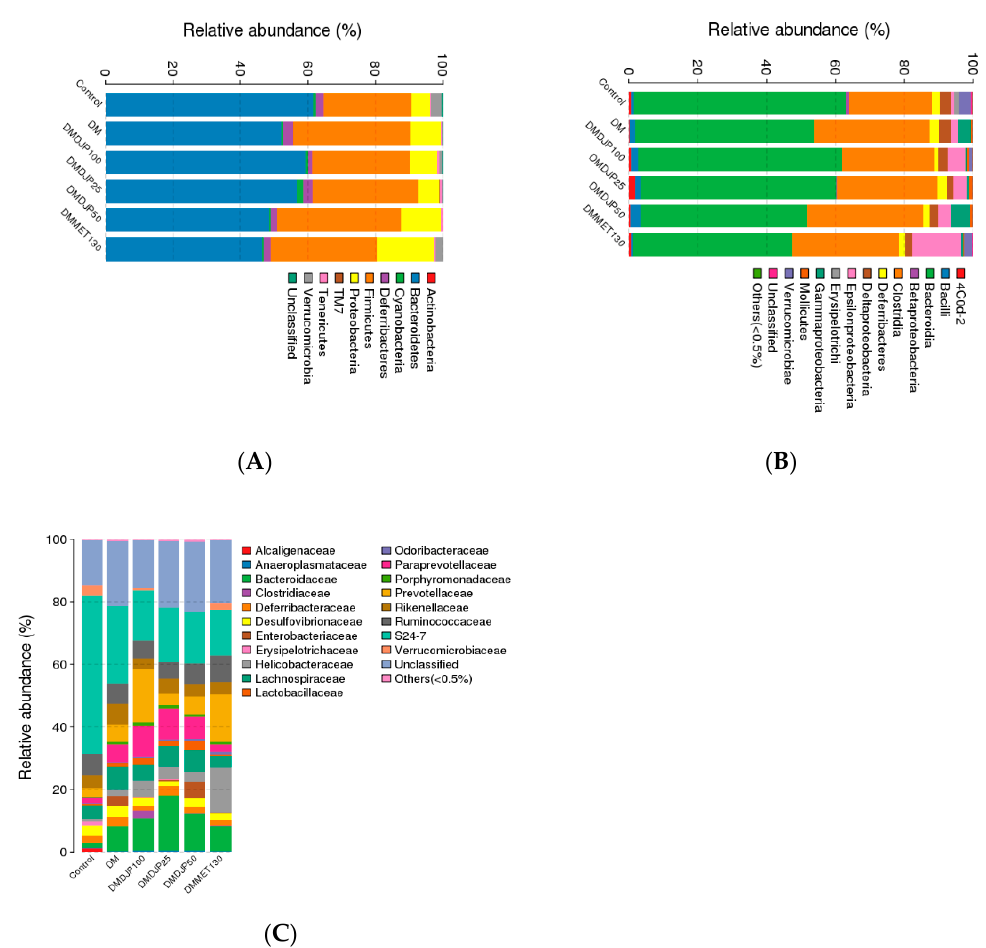
Figure 9. Taxonomic composition of gut microbiome in the mice. ( A ) Phylum-level; ( B ) Class-level; ( C ) Species-level.